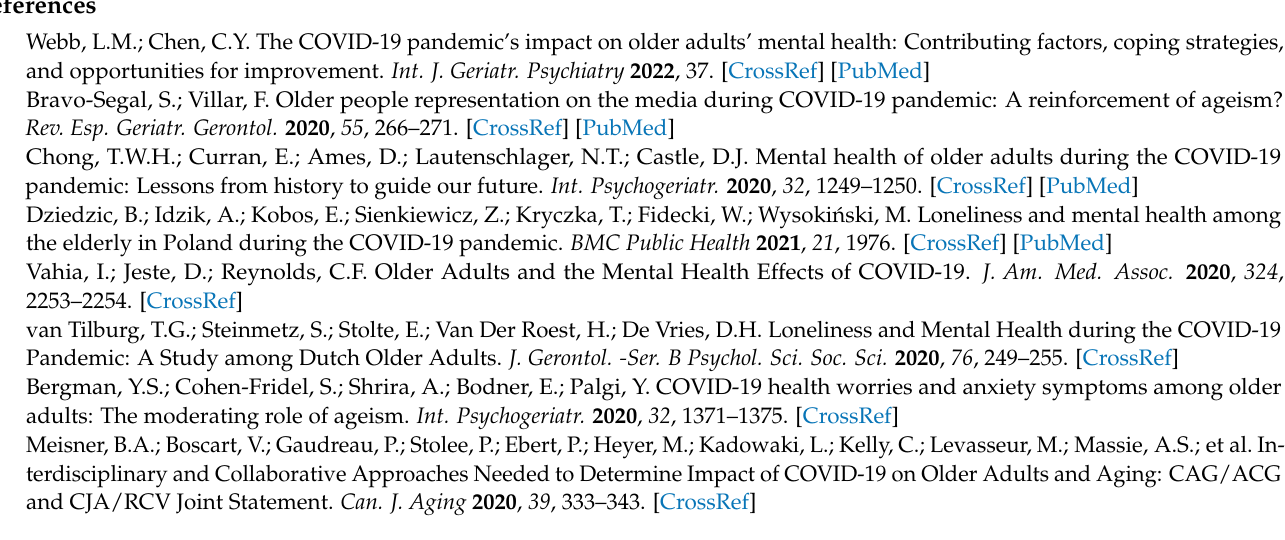
Table S2: Full Bivariate and Multivariable Modeling: Correlates of depressive symptoms; Table S3: Full Bivariate and Multivariable Modeling: Correlates of having Generalized Anxiety Disorder; Table S4: Stressors reported by OPWH during first COVID-19 Lockdown in Kyiv; Table S5: Peer Support Preferences of OPWH in